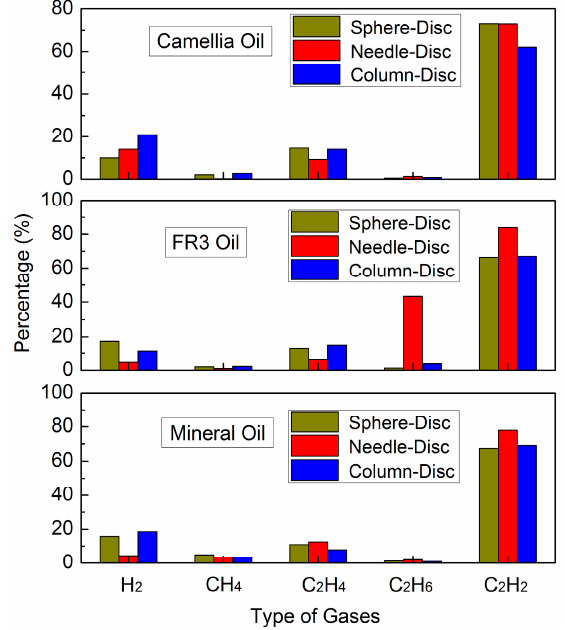
Figure 11. Relative percentages of fault gases in oil under breakdown.